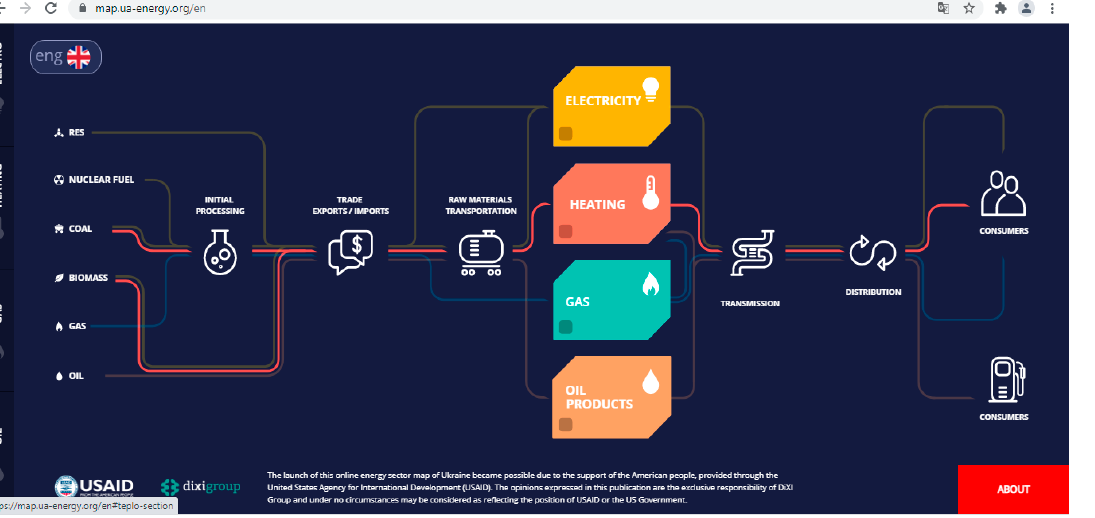
Figure 7. Interactive online map of the energy sector of Ukraine «UA MAP» (reproduction of graphic material from [35]).